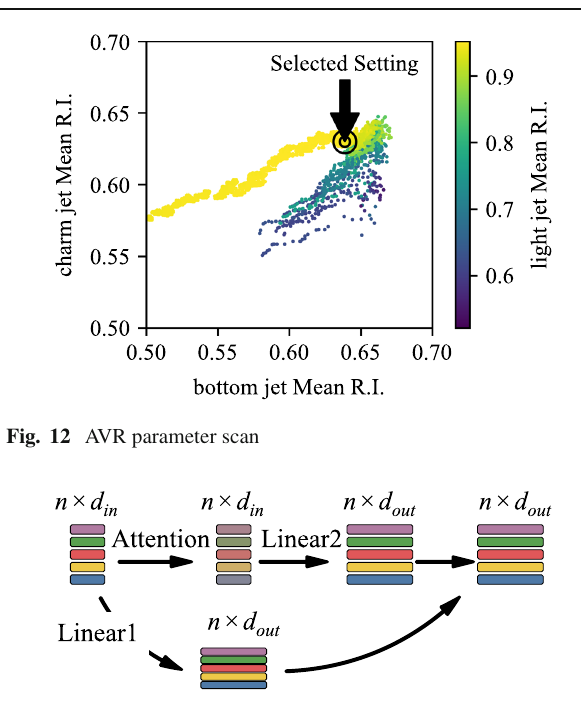
Fig. 12. The working point that was chosen had the